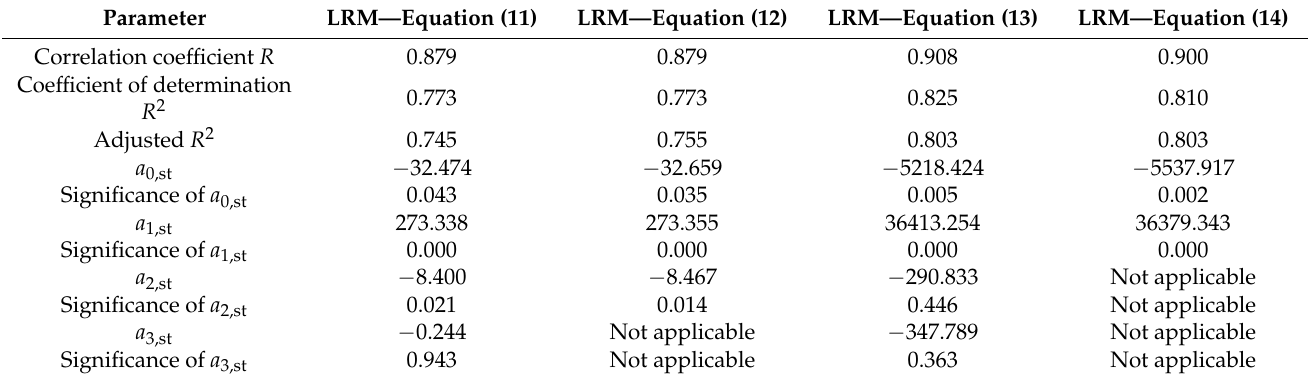
Table 5. Summary of the LRMs for the static properties of the spruce